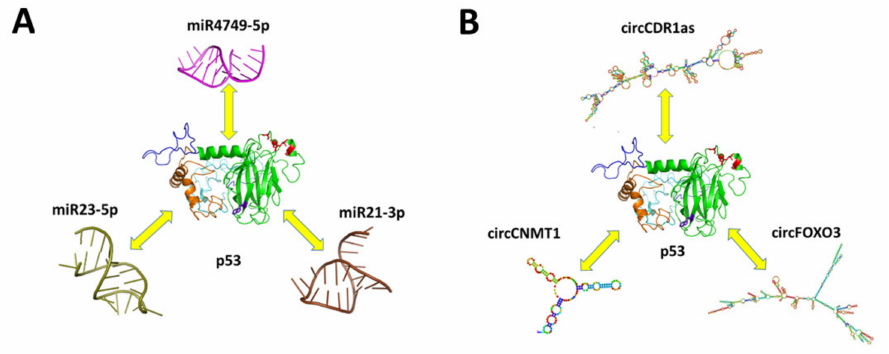
Figure 13. ( A ) Overview of the miRNAs directly interacting with p53. ( B ) Overview of the circRNAs directly interacting with